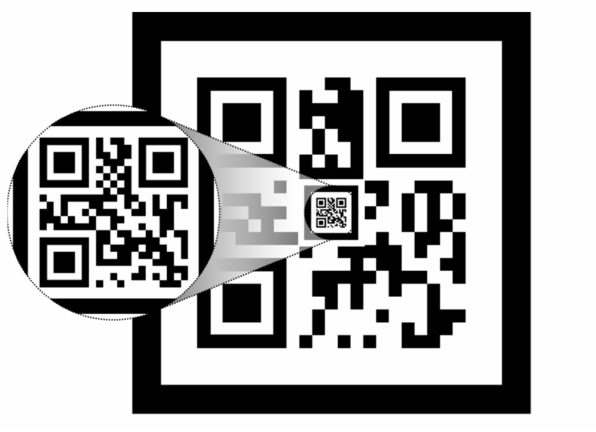
Figure 5. 2-D nested marker.